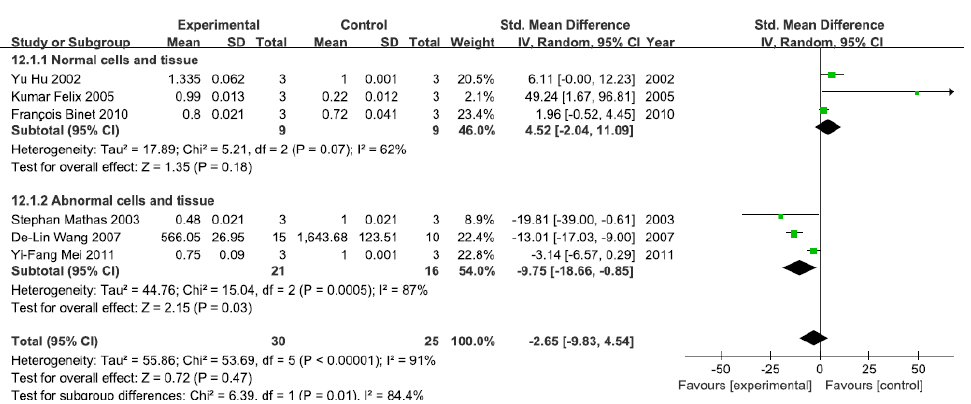
Figure 8. Effects of arsenic on the DNA ‐ binding activity of the nuclear transcription factor kappa B(DNA ‐ binding activity of NF ‐κ B). Forest plot showing the impact of arsenic treatment on the DNA ‐ binding activity of NF ‐κ B compared with controls. Abbreviations: SMD = standardized mean difference, IV = independent variable, 95% CI = 95% confidence interval.